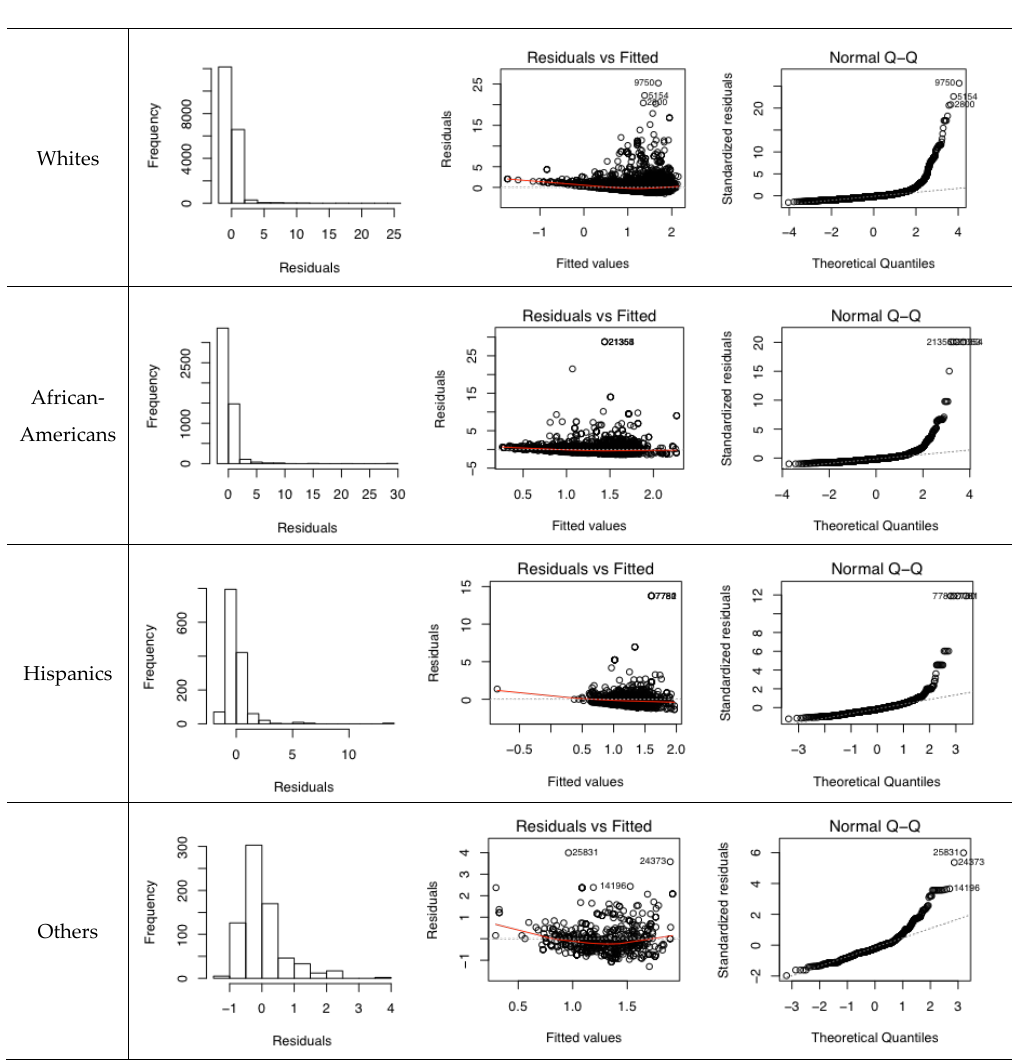
Figure 3. Diagnostic plots of multiple linear regression models.